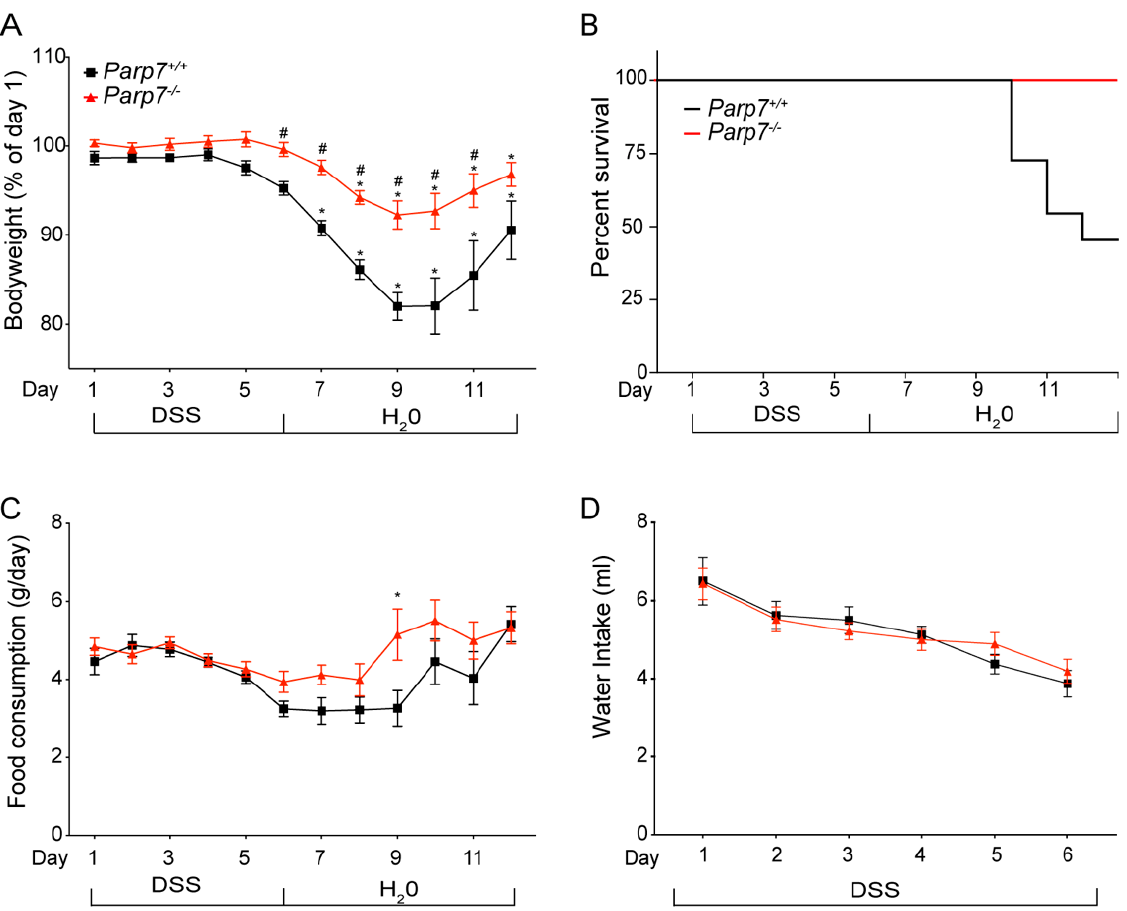
Figure 2. Parp7 − / − mice have reduced sensitivity to DSS-induced colitis. ( A ) Parp7 − / − mice exhibit less weight loss than Parp7 +/+ mice after exposure to 2% DSS in their drinking water. ( B ) Kaplan-Meier survival curves for Parp7 − / − and Parp7 +/+ mice after exposure to 2% DSS in their drinking water. ( C ) Food consumption and ( D ) water intake of Parp7 − / − and Parp7 +/+ mice at the indicated days. * p < 0.05 two-way ANOVA compared with day 1 genotype-matched mice. # p < 0.05 two-way ANOVA compared with time matched Parp7 +/+ mice.